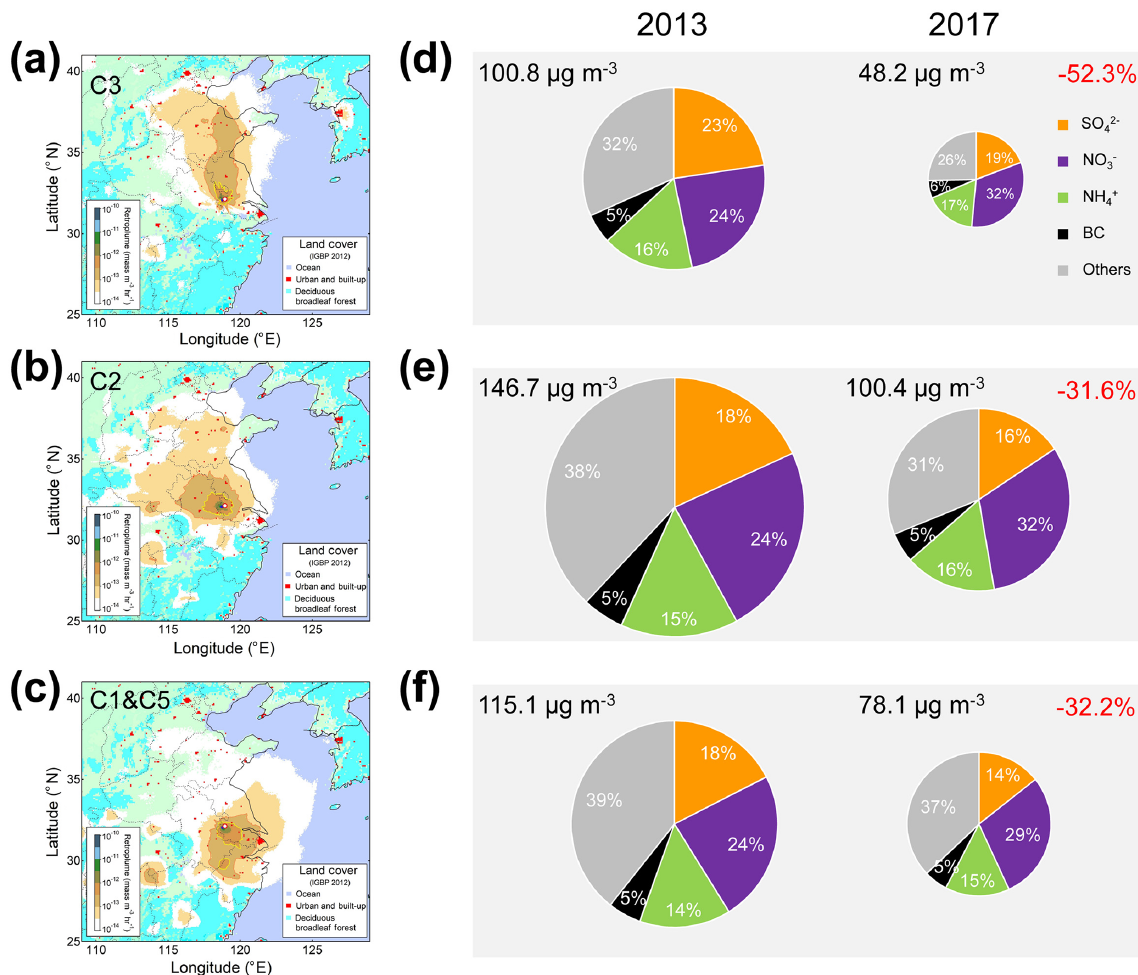
Figure 7. Averaged retroplume for air masses from (a) NCP (C3 in Fig. S1), (b) central–eastern China plain (C2 in Fig. S1), and (c) YRD (C1 and C5 in Fig. S1), and (d–f) a comparison of pie charts of SNA and BC in PM 2 . 5 for the three types of air masses in NDJ of 2013 (November and December 2013 and January 2014) and 2017 (November and December 2017 and January 2018), corresponding to the three transport pathways of different air masses given in (a–c) . Note: averaged PM 2 . 5 concentrations for the corresponding air masses and periods are shown in the top left of each pie chart and also indicated by the size of the pie charts. The reduction rates between the two periods are shown in red in the top right of right panel (in